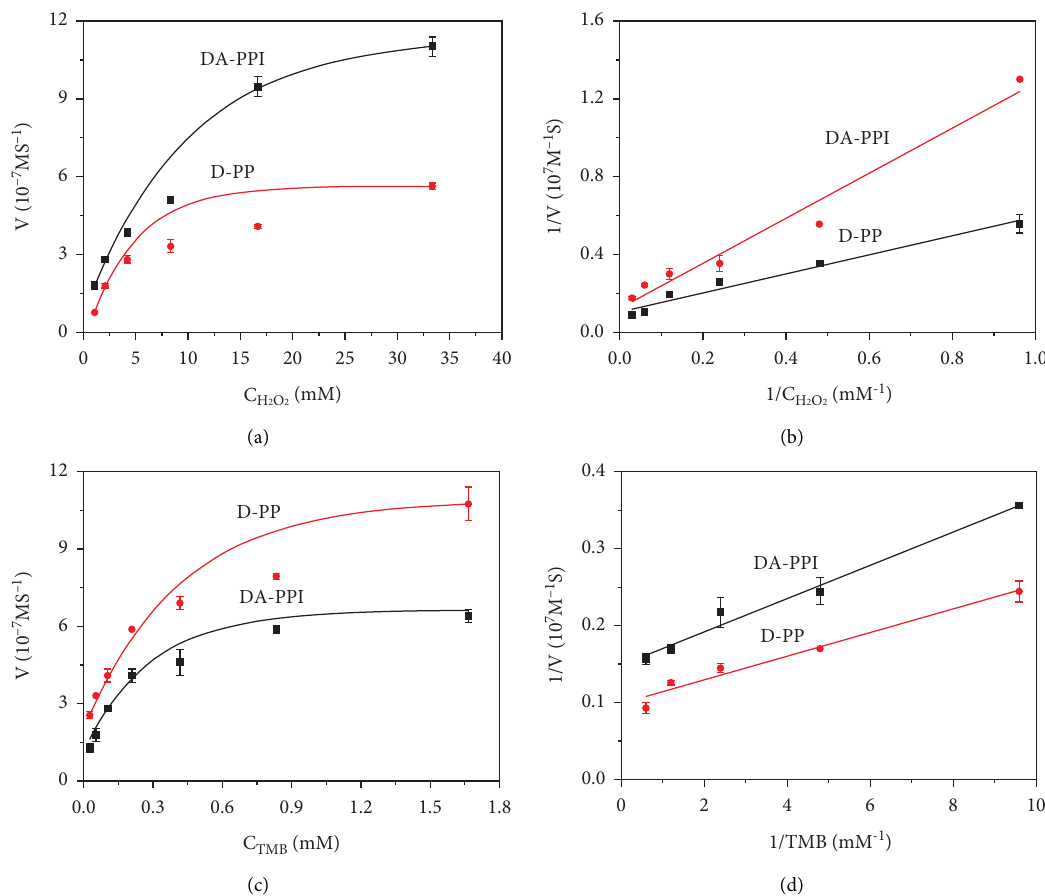
Figure 4: Te enzyme kinetic analysis of D-PP nanozyme and DA-PPI nanozyme for H2O2 (a); the enzyme kinetic analysis of D-PP nanozyme and DA-PPI nanozyme for TMB (b); the double-reciprocal plot generated from Figure 4(a) (c); the double-reciprocal plot that generated from Figure 4(b) (d).